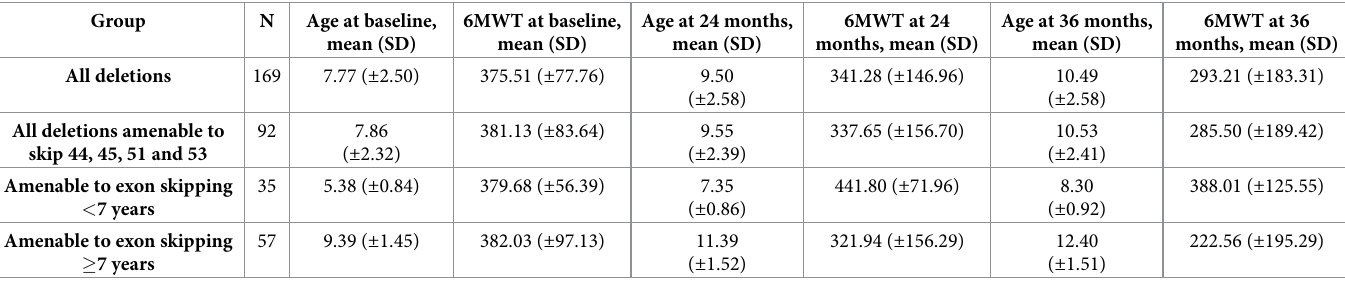
Table 1. Details of the 6MWT in the whole group and in the study